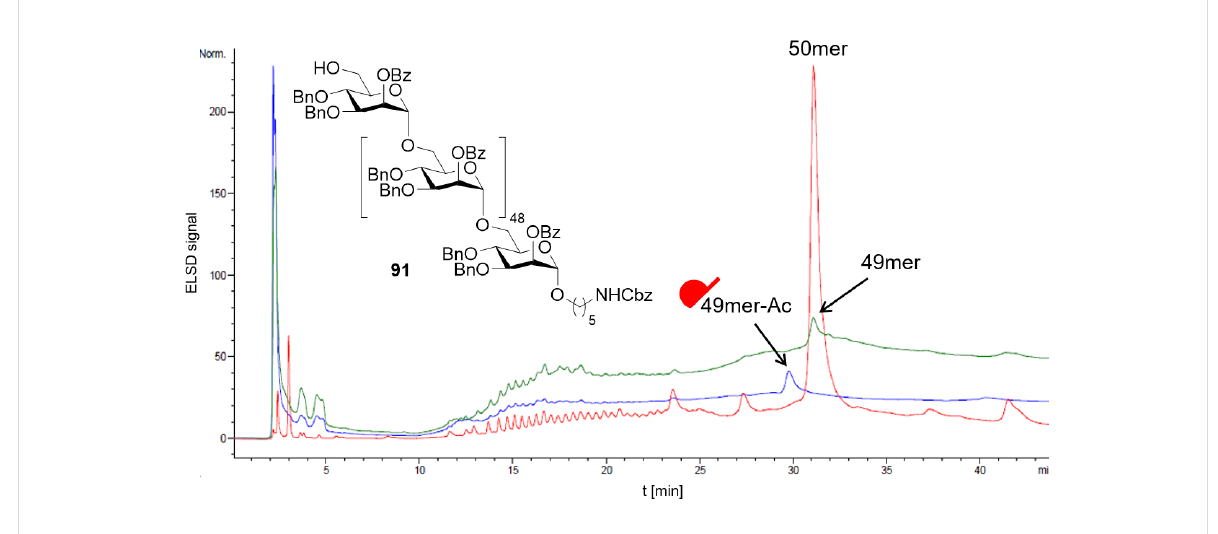
Figure 6: Implementation of a capping step after each glycosylation cycle for the AGA of a 50mer oligomannoside 91 . Uncapped 50mer and 49mer deletion sequence are eluted with virtually the same retention time. The capped 49mer (i.e., C-6 O -acetylated) is instead readily separated from the desired 50mer.